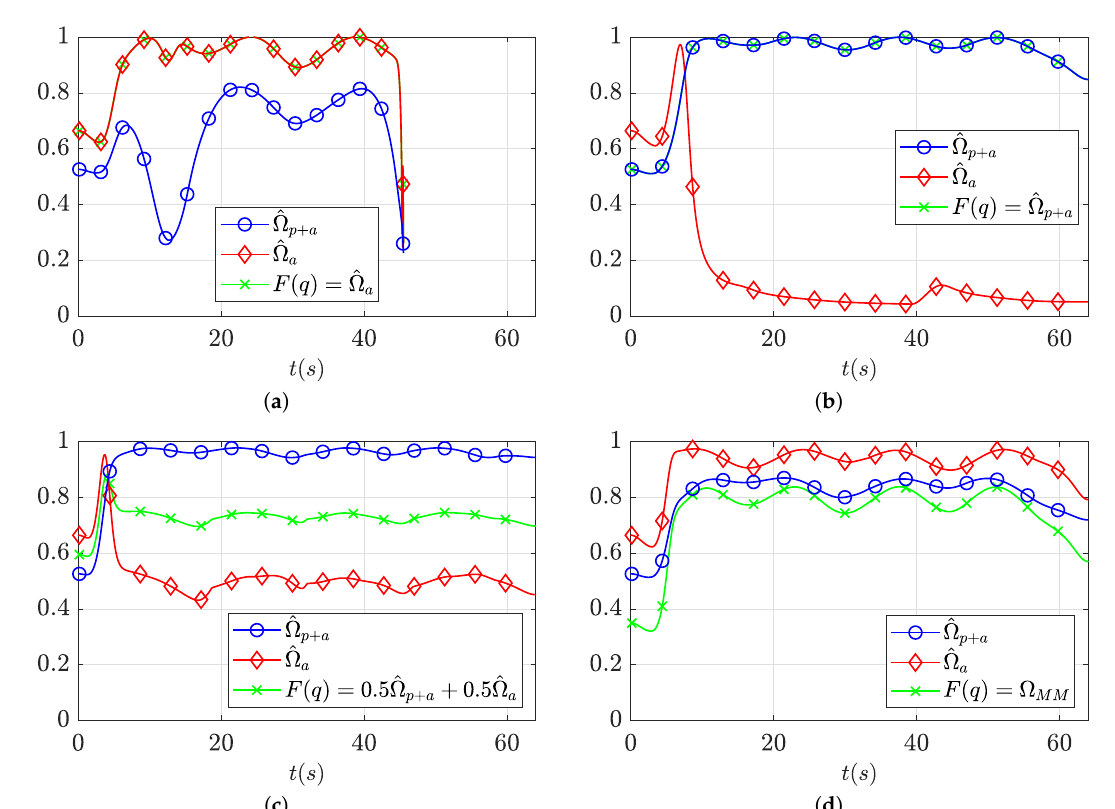
Figure 9. Lissajous trajectory’s comparison of objective functions for manipulability maximization in simulations: ( a ) maxi- mization of the manipulability of the arm; ( b ) maximization of the manipulability of the whole system; ( c ) maximization of a linear combination of the manipulability of the arm and the whole system; and ( d ) maximization of the proposed mobile manipulator manipulability measure. This figure demonstrates the advantages of the manipulability measure for mobile manipulators (panel ( d )) presented in Section 4.1. See Section 5.4 for a detailed discussion of this